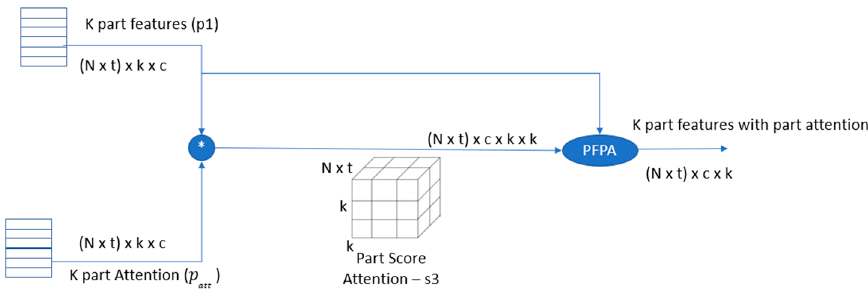
Figure 7. Analyzing the Effect of different K-Parts on the mAP and Rank1 score.